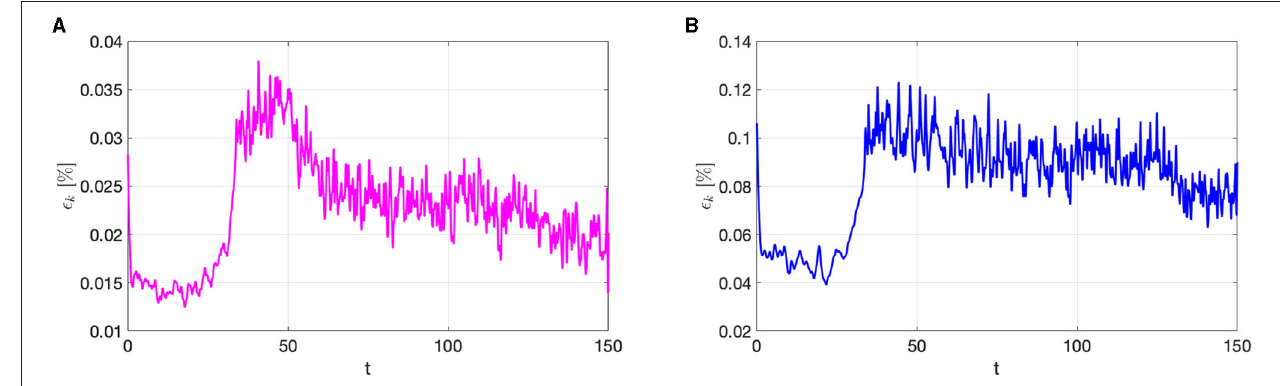
FIGURE 3 | Test 1.1 : Relative error ǫ k , averaged with respect to the spatial coordinates, for the transmembrane (A) and the extracellular (B) potentials, for the testing-parameter instance µ test = 0.0143 (cid:127) − 1 cm − 1 , over time.